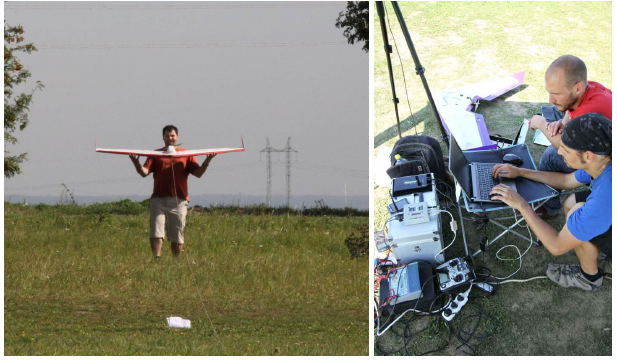
Figure 13. Flight tests of the multi-UAV